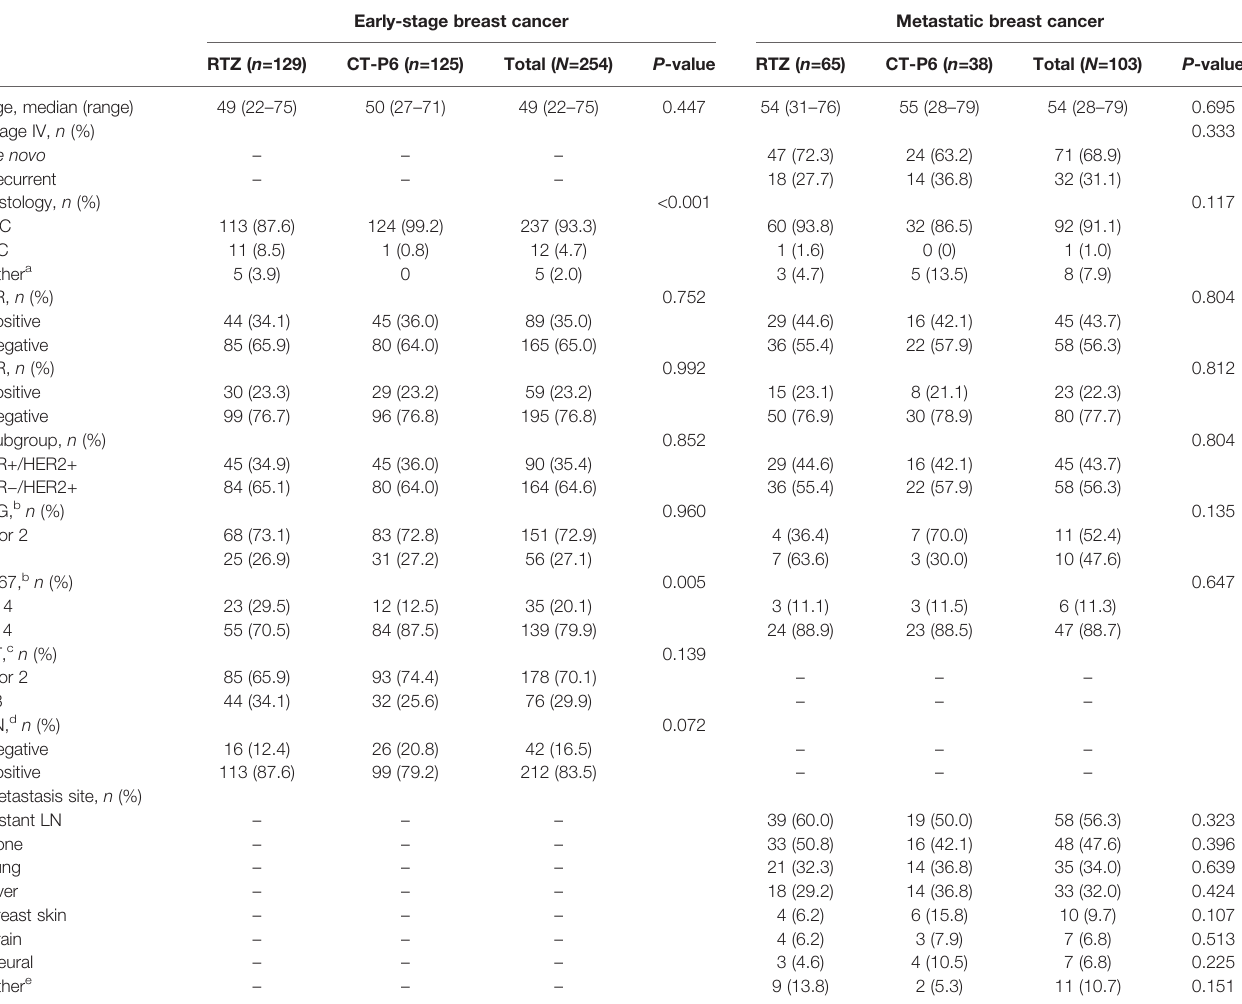
TABLE 1 | Baseline characteristics of patients with HER2-positive early-stage and metastatic breast